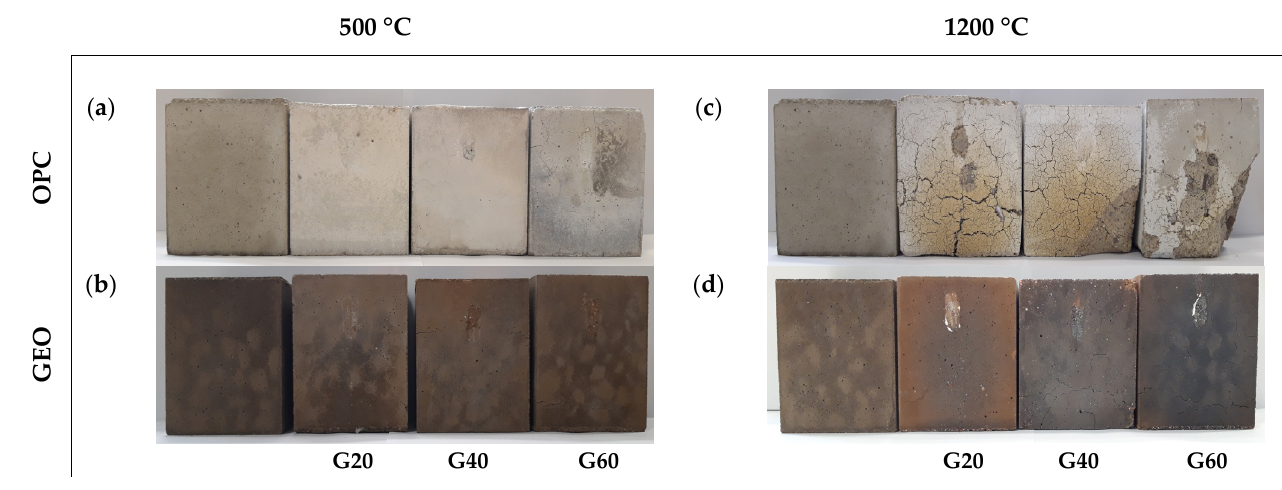
Figure 3. Visual observation of concrete in cm/cube: ( a ) OPC at 500 °C; ( b ) GEO at 500 °C; ( c ) OPC at 1200 °C; ( d ) GEO at 1200 °C.